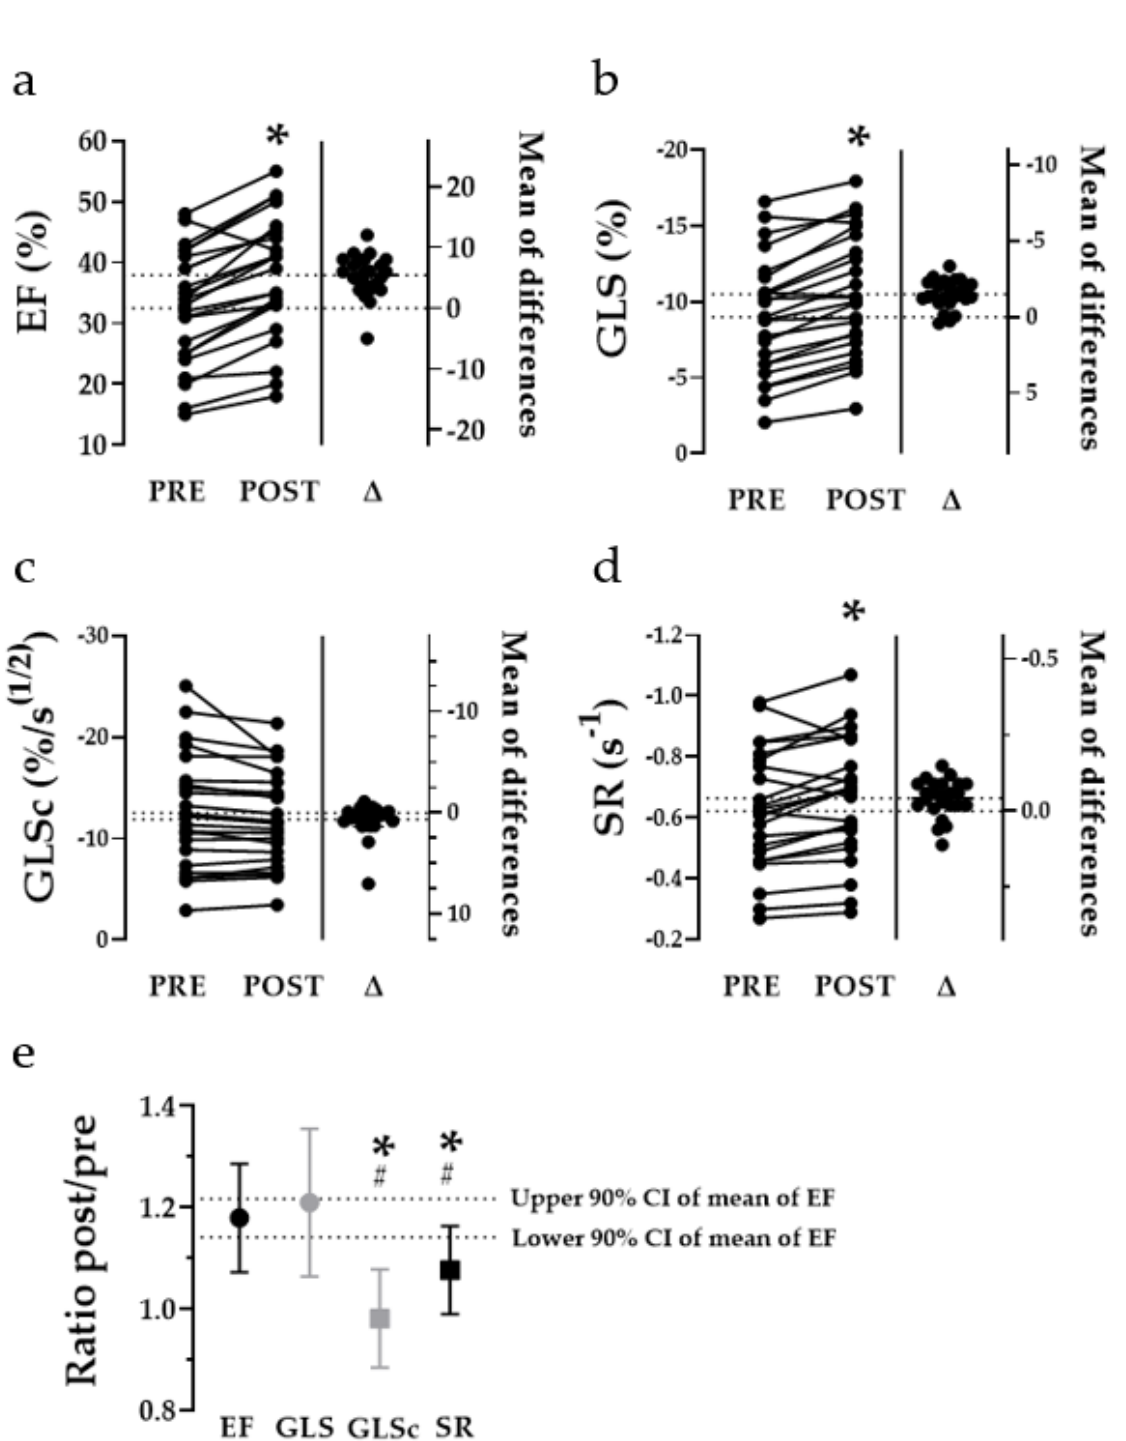
Figure 4. Measures of systolic LV function. Estimation plots showing an increase of EF, GLS and SR pre vs. post ECV ( a , b , d ), whereas GLSc showed no significant difference ( c ). ( e ) Scatter plot of the ratios (post/pre) of EF, GLS, GLSc and SR. * indicates p < 0.05 vs. pre ( a , b , d ) and vs. EF ( e ), # indicates p < 0.05 vs. GLS ( e ). EF, ejection fraction; GLS, global longitudinal strain; SR, strain rate; ECV, electrical cardioversion; GLSc, global longitudinal strain corrected for RR interval.